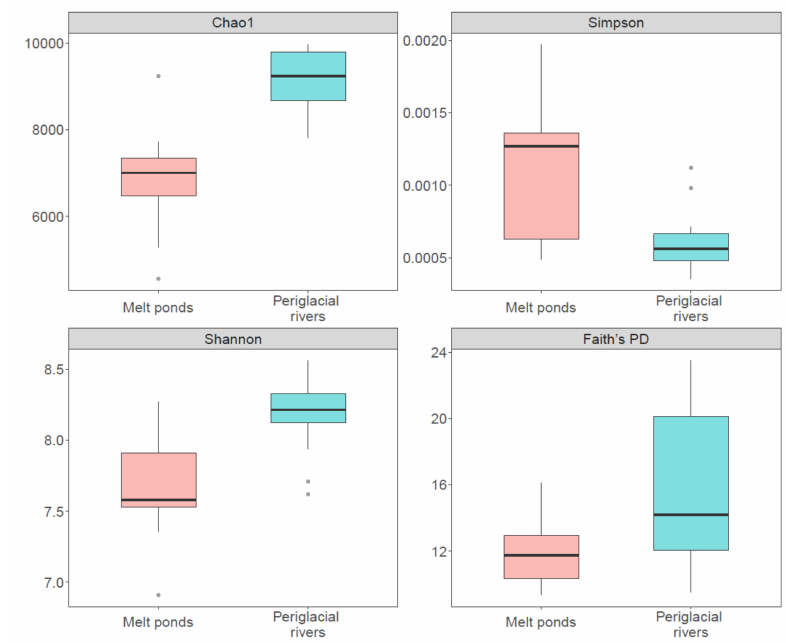
Figure 3. The alpha-diversity of bacterial communities in melt ponds and periglacial